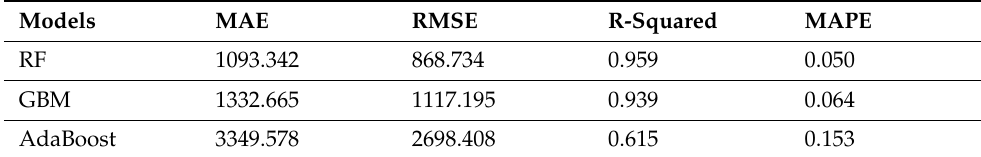
Table 4. Prediction results of single ML